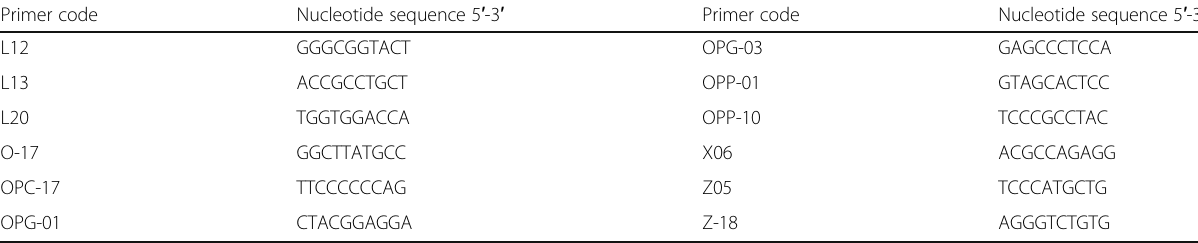
Table 2 The sequence of the oligonucleotide primers used for the RAPD-PCR analysis Primer